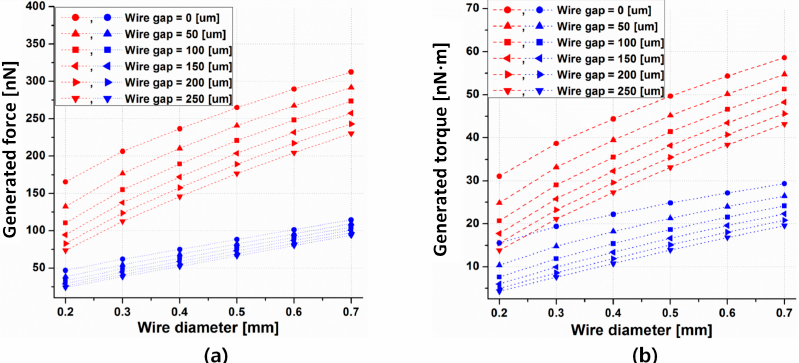
Figure 6. Simulated force ( a ) and torque ( b ) under the allowable current according to the wire diameter of the load coil.